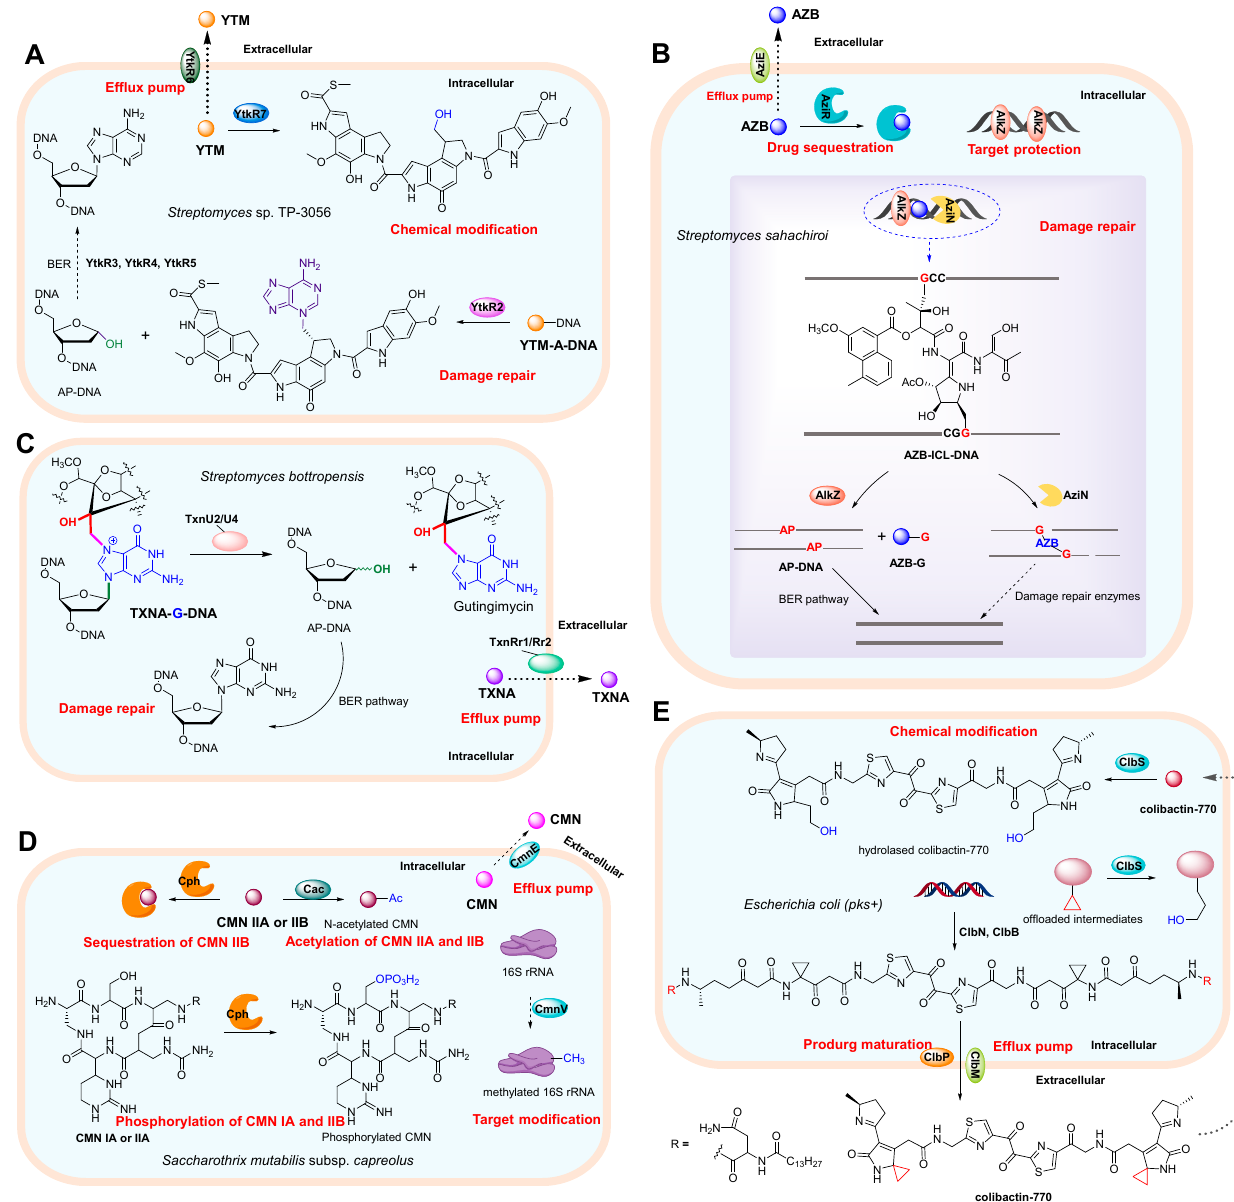
Figure 3. Examples of intracellular multi-level resistance model. ( A ) Self-resistance strategies employed by yatakemycin (YTM) producing strain Streptomyces sp. TP-3056. The producer is known to be protected by seven resistance genes that function in efflux pumps, chemical modification and damage repair. ( B ) Self-protection mechanisms of azinomycin B (AZB) producing strain Streptomyces sahachiroi. The drug-bind protein AziR, transmembrane export protein AziE, DNA damage